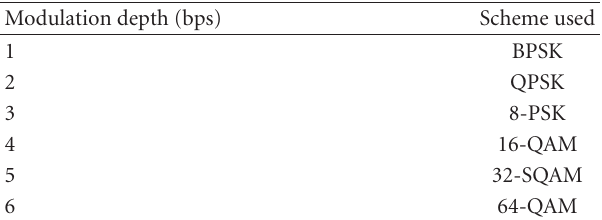
Table 3: Modulation schemes used for each bit per symbol